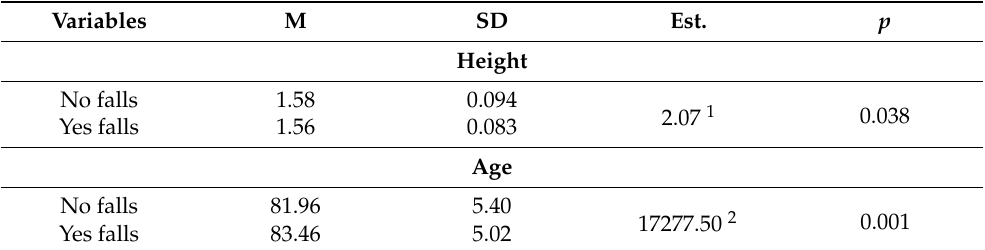
Table 5. Existence of falls based on socio-demographic quantitative